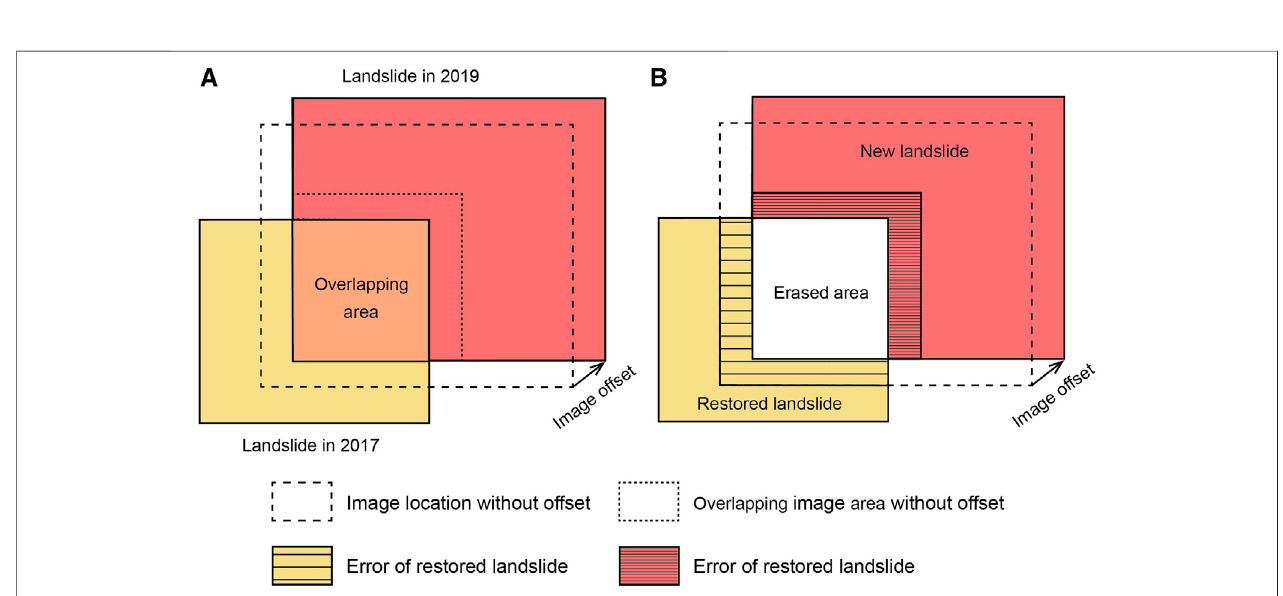
FIGURE 3 | Principle of change detection with offset (A) Dislocation in the two images (B) Change detection of landslide with image offset. The error of restored landslide: The change detection error of the new landslide is caused by an image offset. The error of restored landslide: The change detection error of the restored landslide is caused by an